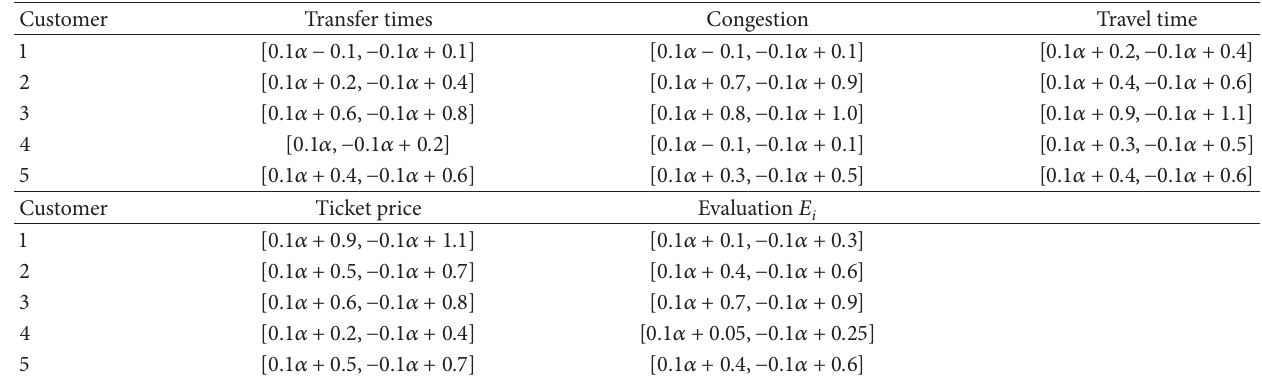
Table 10: The triangular fuzzy number changed into the interval number.